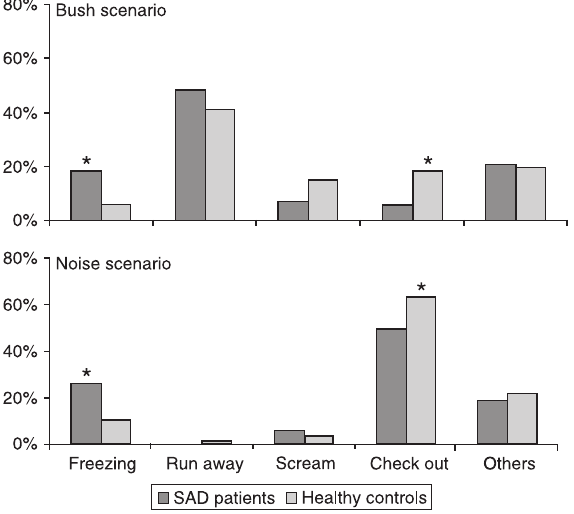
Figure 1. Frequency of first-choice responses to the Bush and Noise scenarios by SAD patients of both genders (N = 87) and matched healthy controls (N = 87). SAD = social anxiety disorder. *Significant differences between groups (P < 0.05, Fisher exact test).